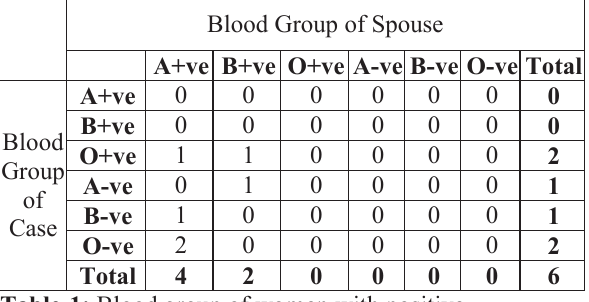
Table-1: Blood group of women with positive